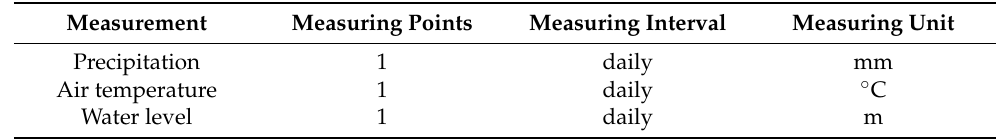
Table 3. Water level and weather record